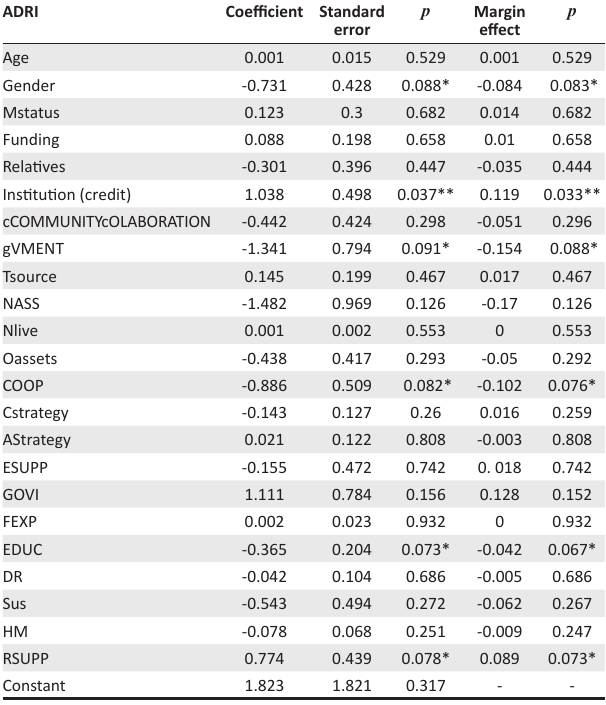
TABLE 5: Factors that affect the farming household’s resilience to agricultural drought.